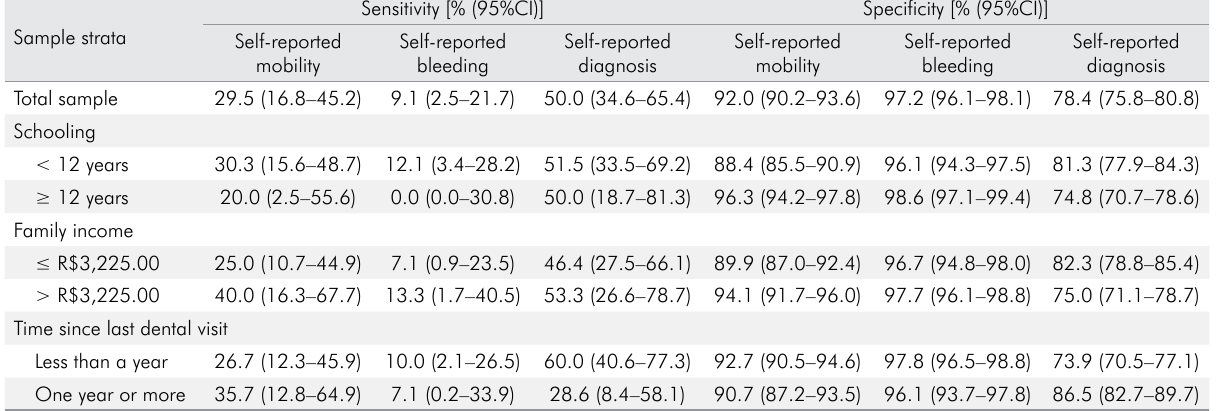
Table 4. Sensitivity, specificity and their 95% confidence intervals for the second clinical definition of periodontitis (≥ 6.0 mm periodontal pocket and clinical attachment loss of 4.0 mm or more, not necessarily in the same tooth).